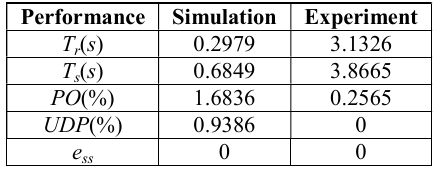
Figure 7. Height position responses of a simulated scissor mechanism platform for (a) Case I (simulation), (b) Case II (simulation), and (c) mean square error, MSE